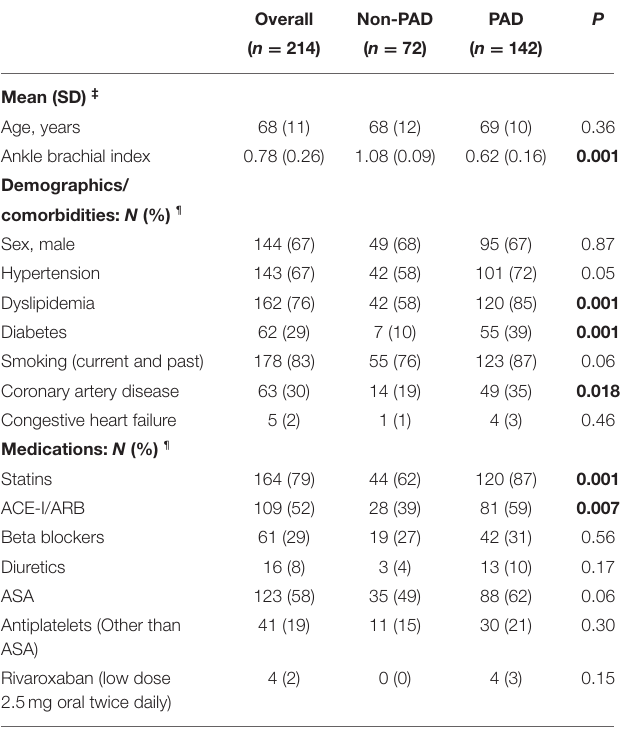
TABLE 1 | Demographic and clinical characteristics of patients with and without peripheral artery disease (PAD).